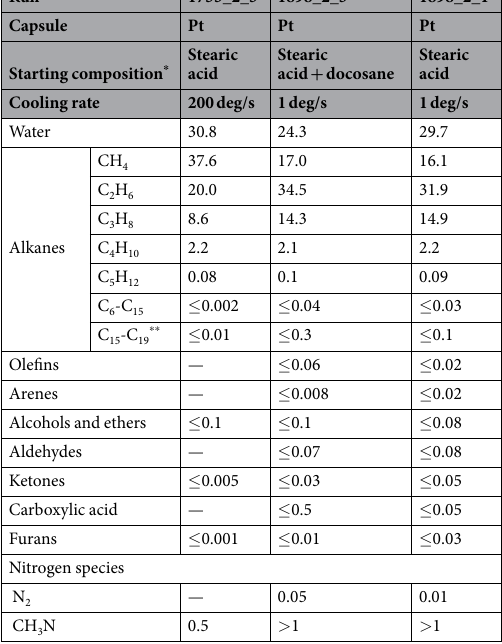
Table 3. Representative analyses of quenched and slow cooling C-O-H-N fluids (rel.%) obtained in 2-hr runs at 6.3 GPa and 1400 °C. * All samples contained graphite. ** The quoted concentrations are maximum for a species of the respective group. All GC-MS data are given in Supplementary Table